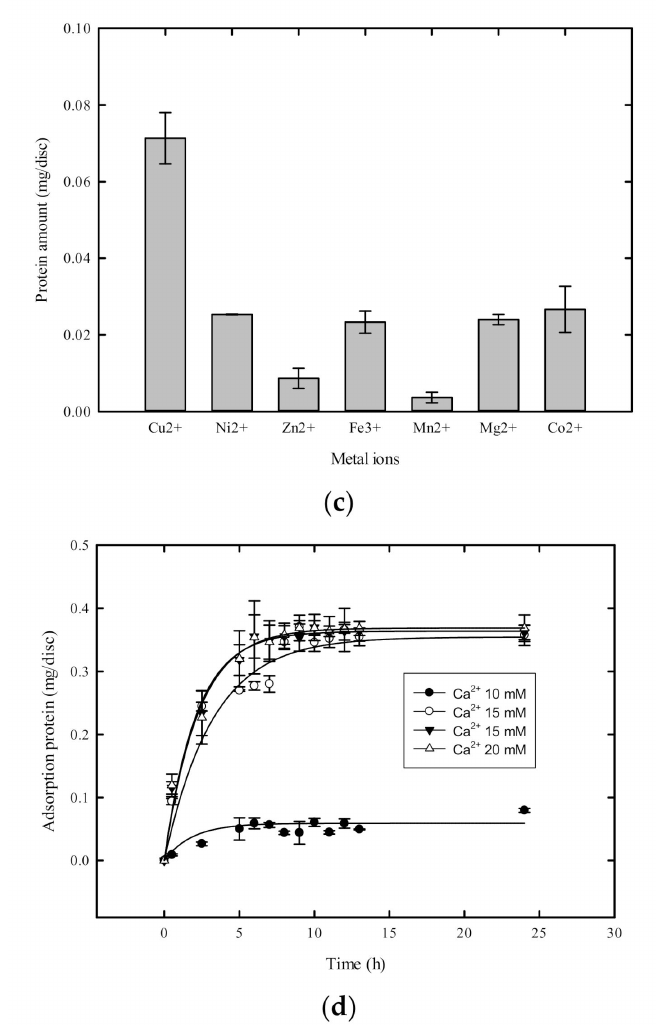
Figure 3. Characterization of the importance of cations in protein absorption and enzyme activities, ( a ) E ff ects of metal ions (50 mM) on the activity of free XynCt, where the asterisks (**) indicate significant di ff erence with p values < 0.05. ( b ). E ff ects of Co 2 + concentration and adsorption time on its chelation in IMAM. ( c ). E ff ect of metal ions on CipA adsorption to the Co 2 + -chelated IMAM. ( d ) E ff ects of Ca 2 + concentration and time on XynCt adsorption level on the IMAM-Co 2 + -CipA. The error bars represent SD, n =